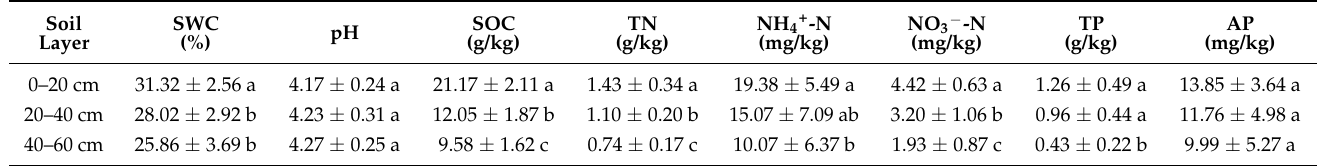
Table 1. Changes in physicochemical properties of soil profiles in native tree plantations (mean ± SD, n =